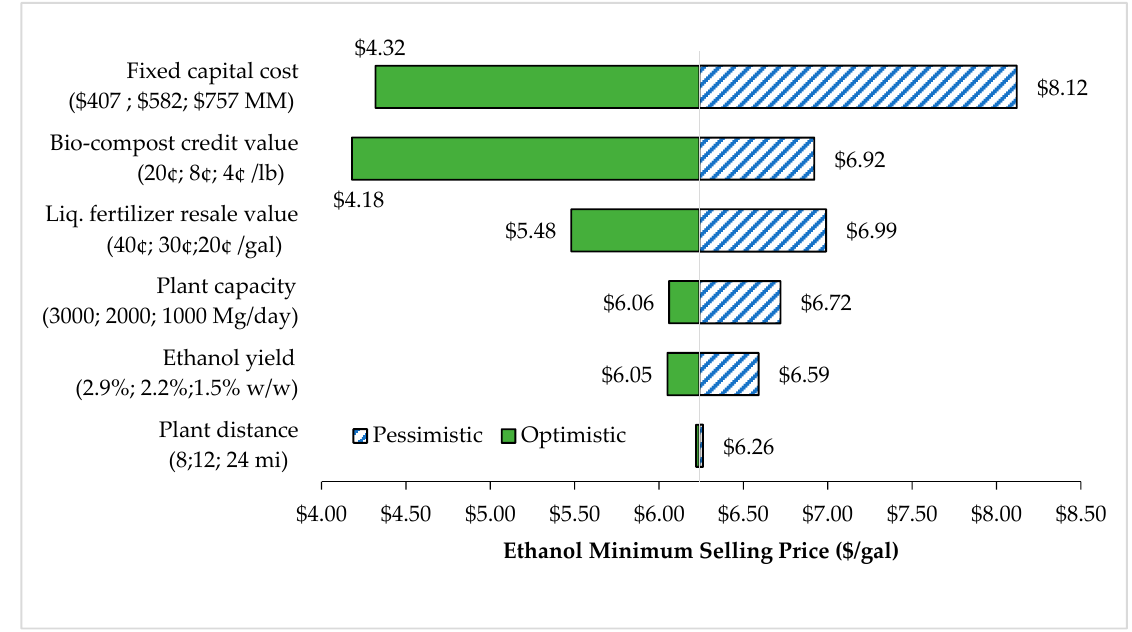
Figure 8. Sensitivity analysis of FW fermentation with membrane distillation separation process. (Optimistic is the best-case scenario simulation, pessimistic is the worst-case scenario simulation).